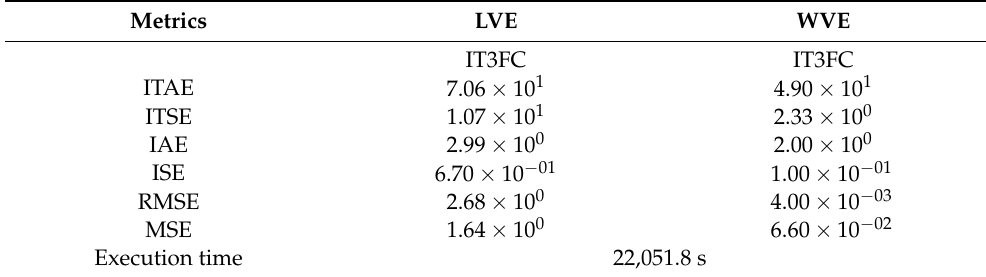
Table 6. Metrics results without noise.